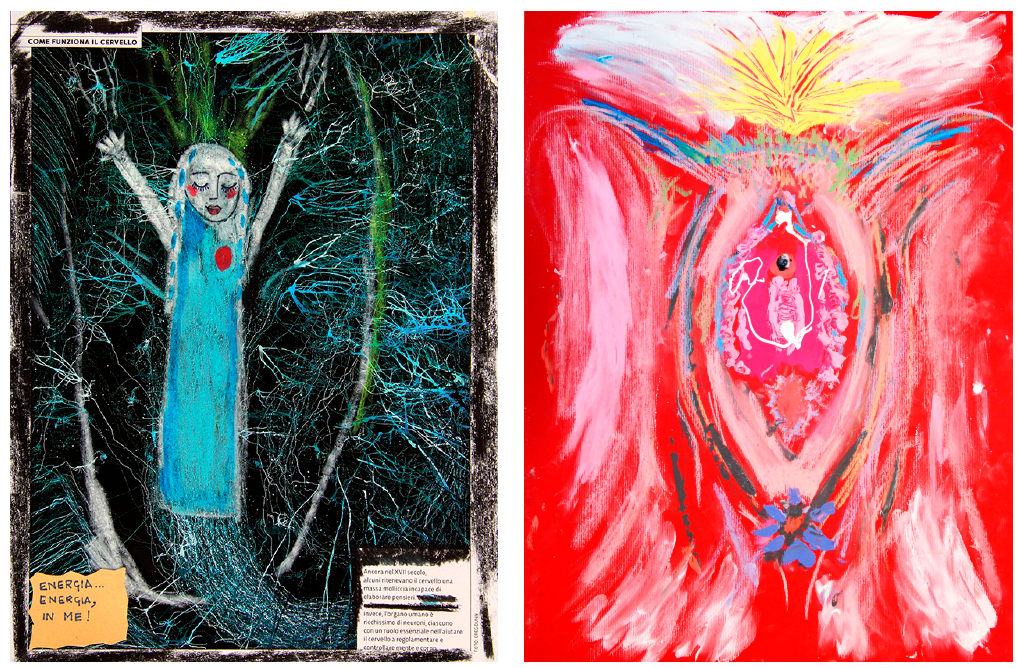
Figure 1. On ( left ) Viviana (aged 45, psychotic disorder), New Energy in Me ; On ( right ) Lucia (aged 54, histrionic personality disorder), It Could Be a